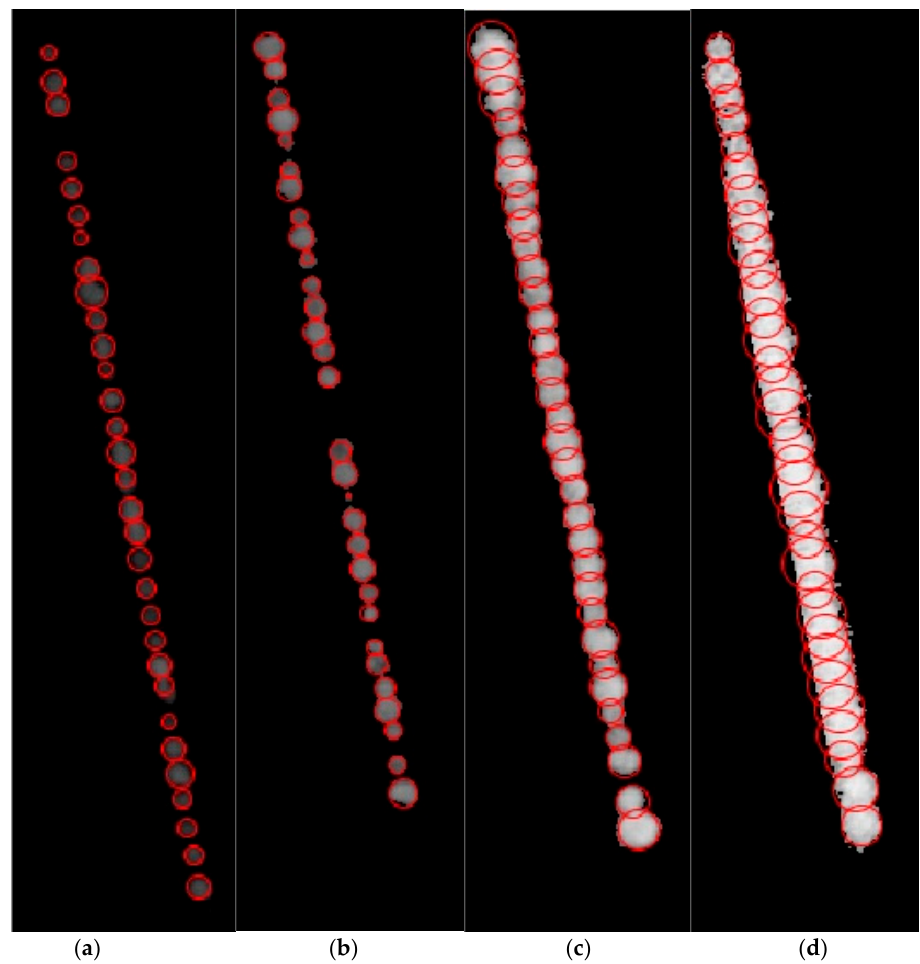
Figure 10. ( a )–( d ) Extraction of circular plant regions and accurate area of individual plants from Figure 8 using Algo- rithm